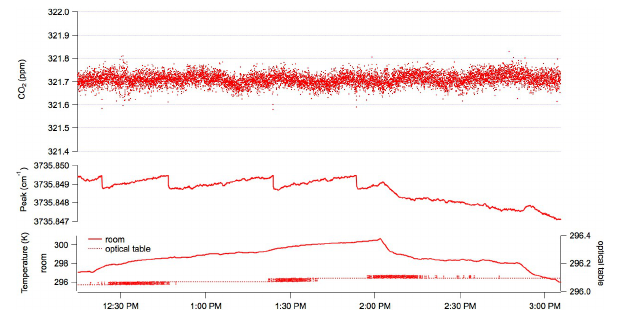
Fig. 6. Instrument performance of measuring a tank source for 12h continuously using the null method. Top panel shows the real-time 1Hz data; bottom panel is the Allan variance plot showing the in- strument’s one-second precision of 0.013ppm, and 0.007ppm with one minute